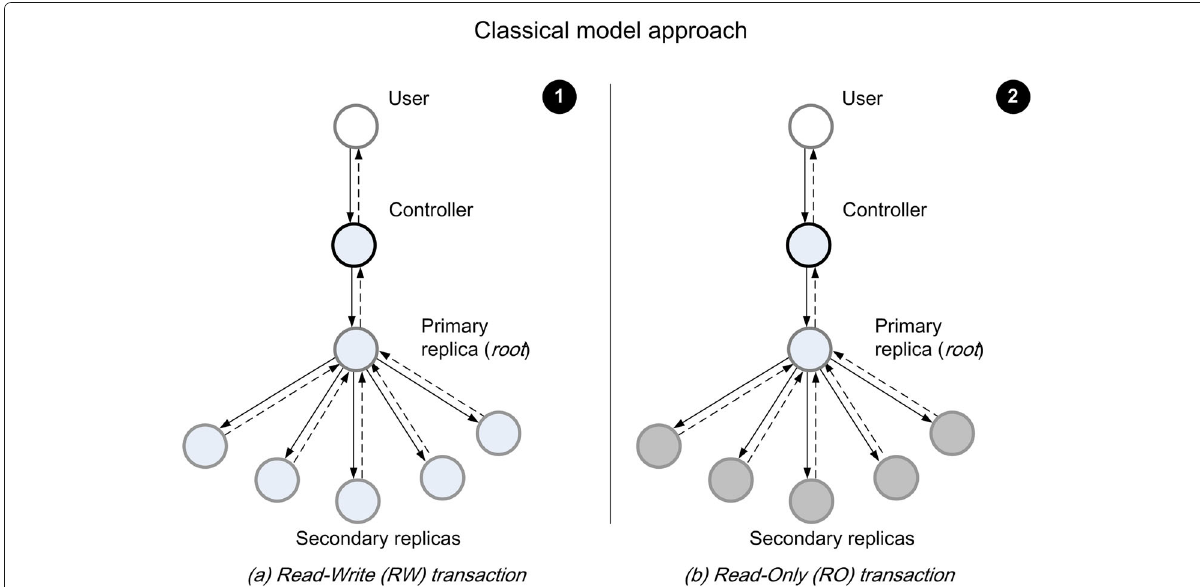
Fig. 1 Standard approach for consistency management - an example of the execution of read and write operations within the Classic approach